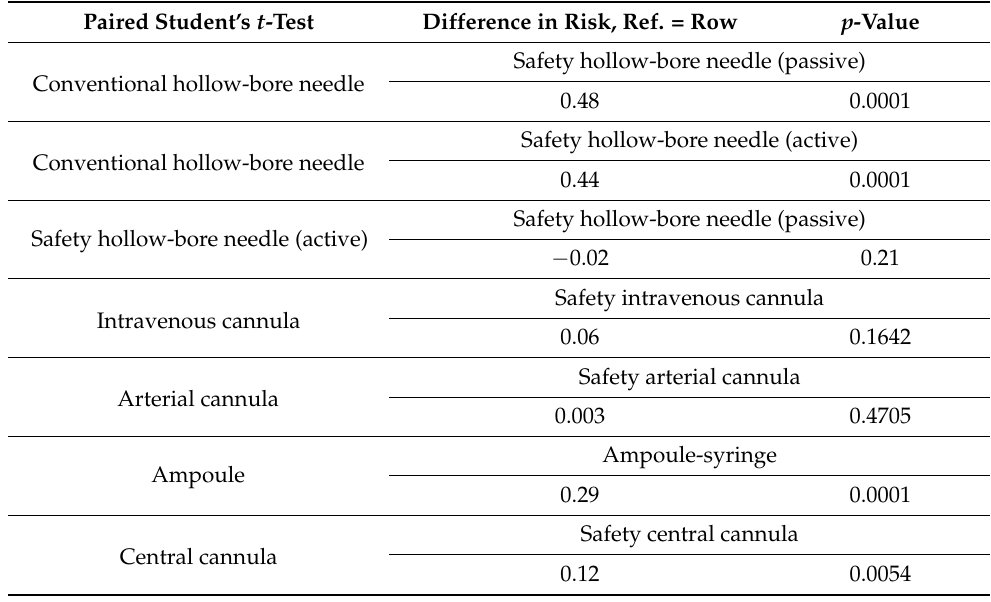
Table 6. Comparison of the risk of injuries with SED and non-SED devices. Paired Student’s t -Test Difference in Risk, Ref. =